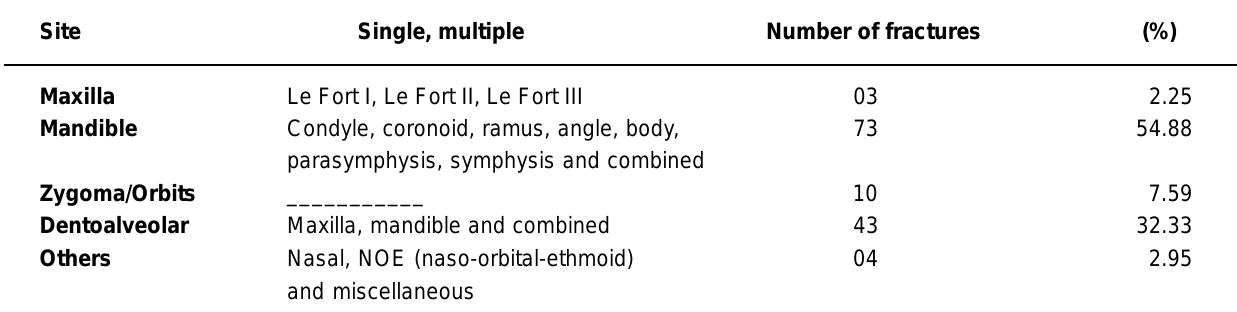
TABLE 1- Classification of maxillofacial fractures